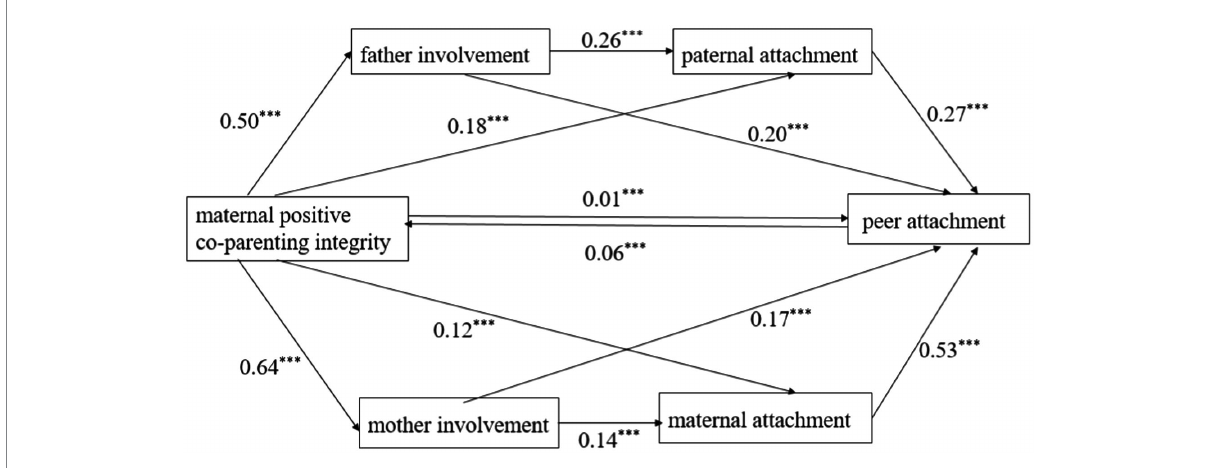
FIGURE 1 Chain mediating of parenting involvement and parent-child attachment between maternal positive co-parenting integrity and peer attachment. *** p <